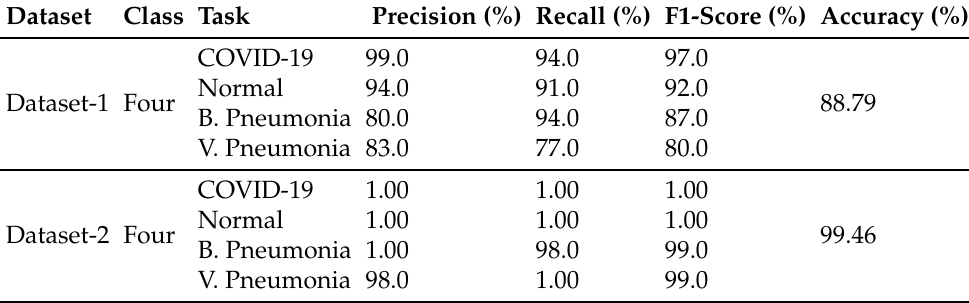
Table 7. Classification performance between Dataset-1 and Dataset-2.